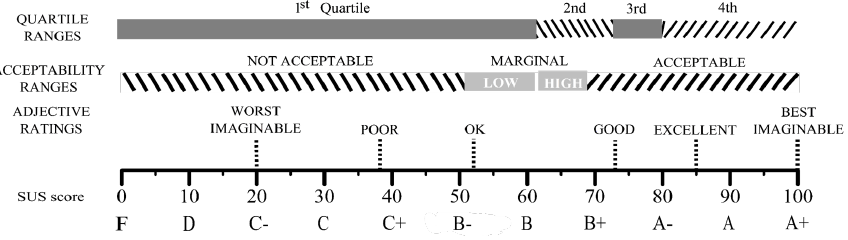
Figure 10. Comparison of the Software Usability Scale (SUS) score by quartiles, acceptability and adjective qualification. Figure adapted from